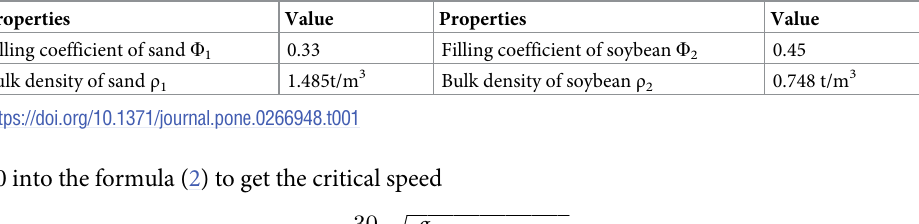
Table 1. Granular material characteristic parameters.